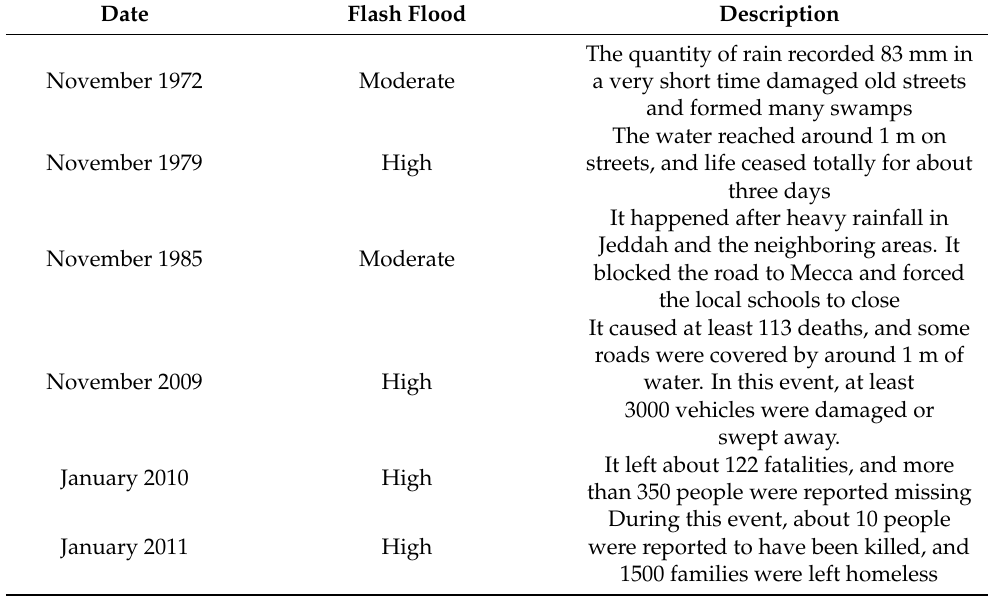
Table 1. Several examples of flash flood events are indicators for the seriousness of destructive flash flooding during the last 50